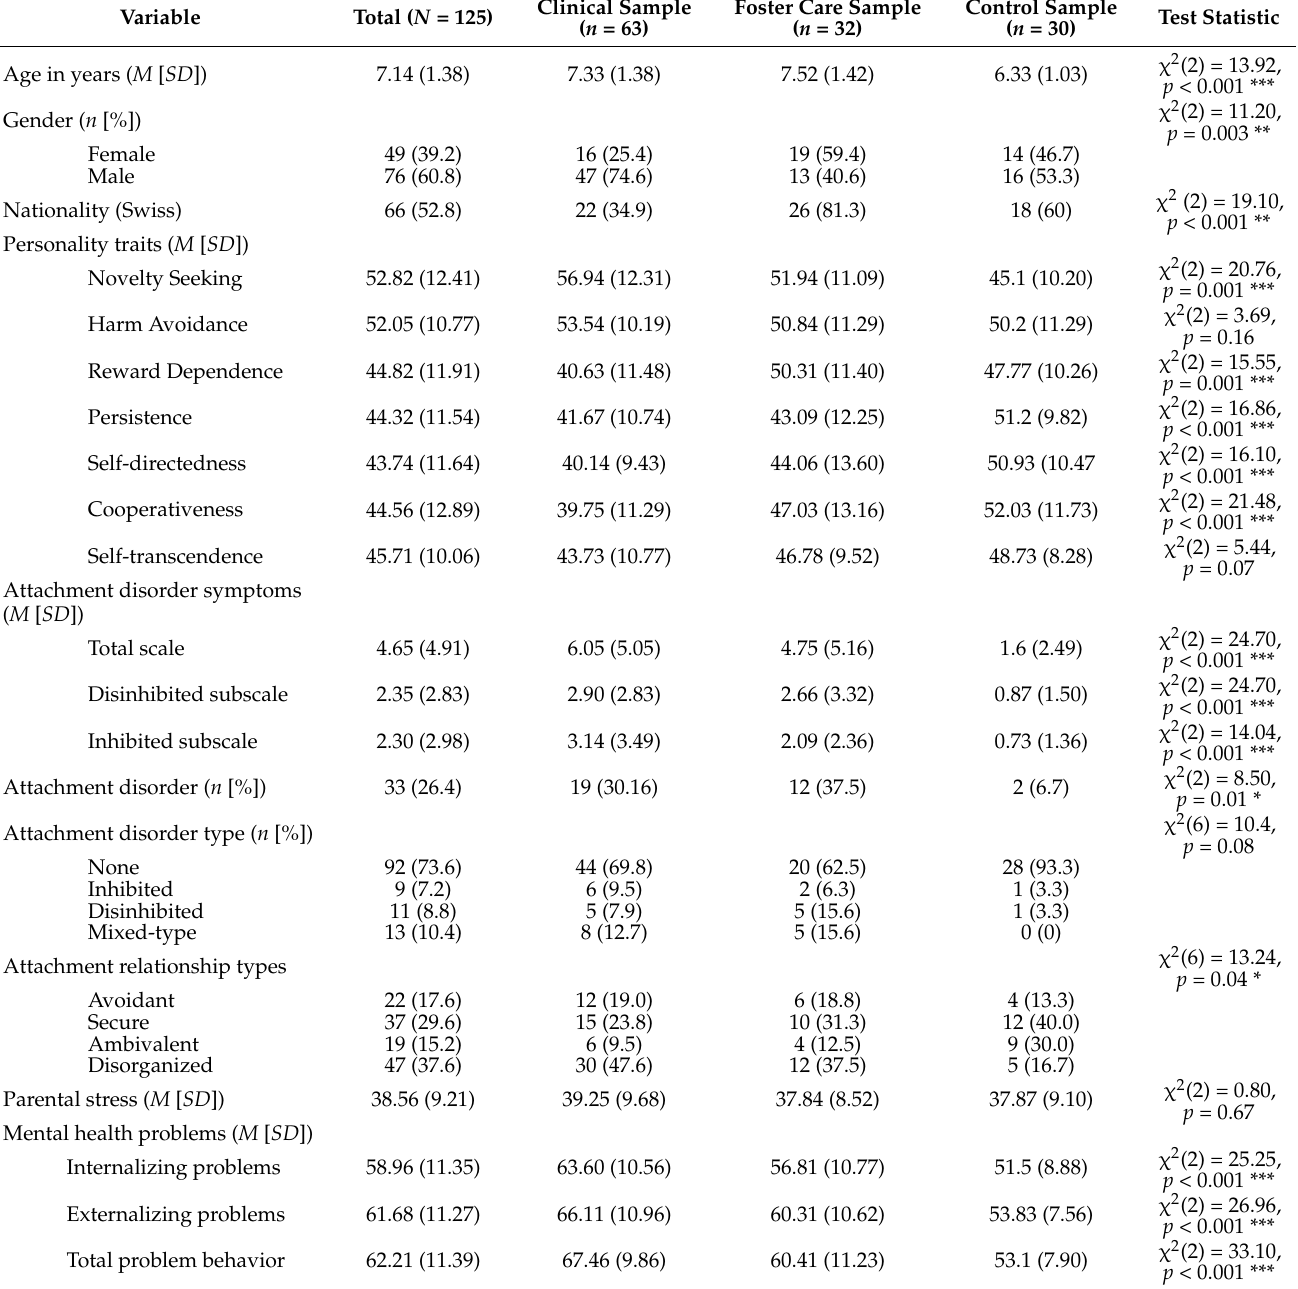
Table 1. Sociodemographic and descriptive characteristics of the total sample and differences between